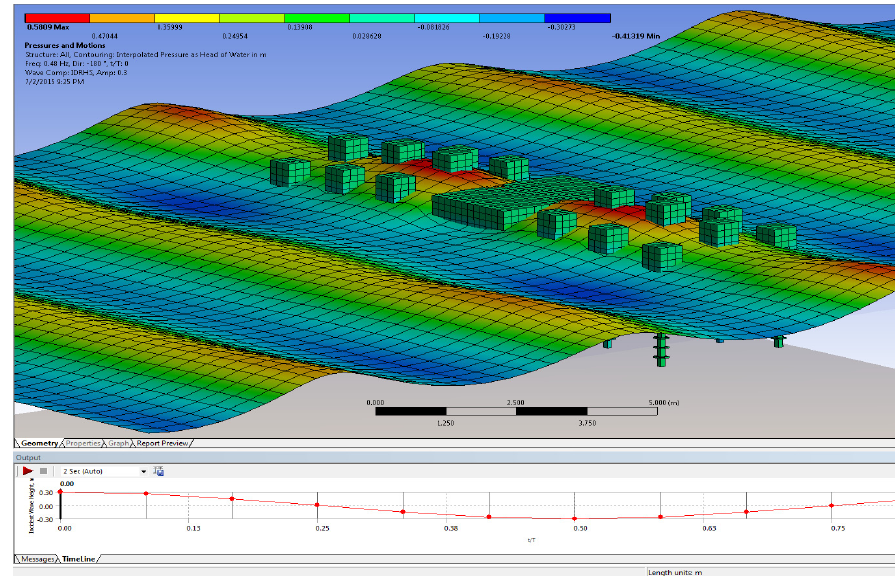
Figure 7. Water pressures and wave motion around the IPMC system installed in the ocean .